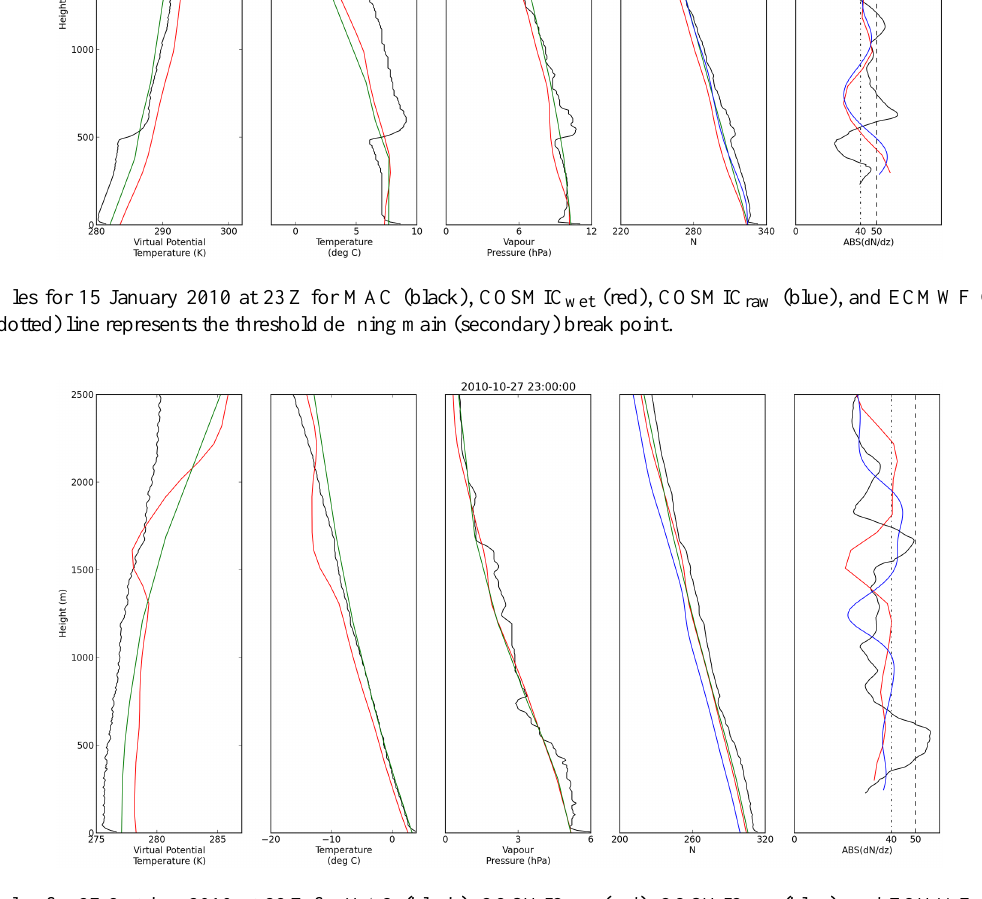
Figure 5. Profiles for 27 October 2010 at 23Z for MAC (black), COSMIC wet (red), COSMIC raw (blue), and ECMWF (green). Vertical dashed (dash-dotted) line represents the threshold defining main (secondary) break